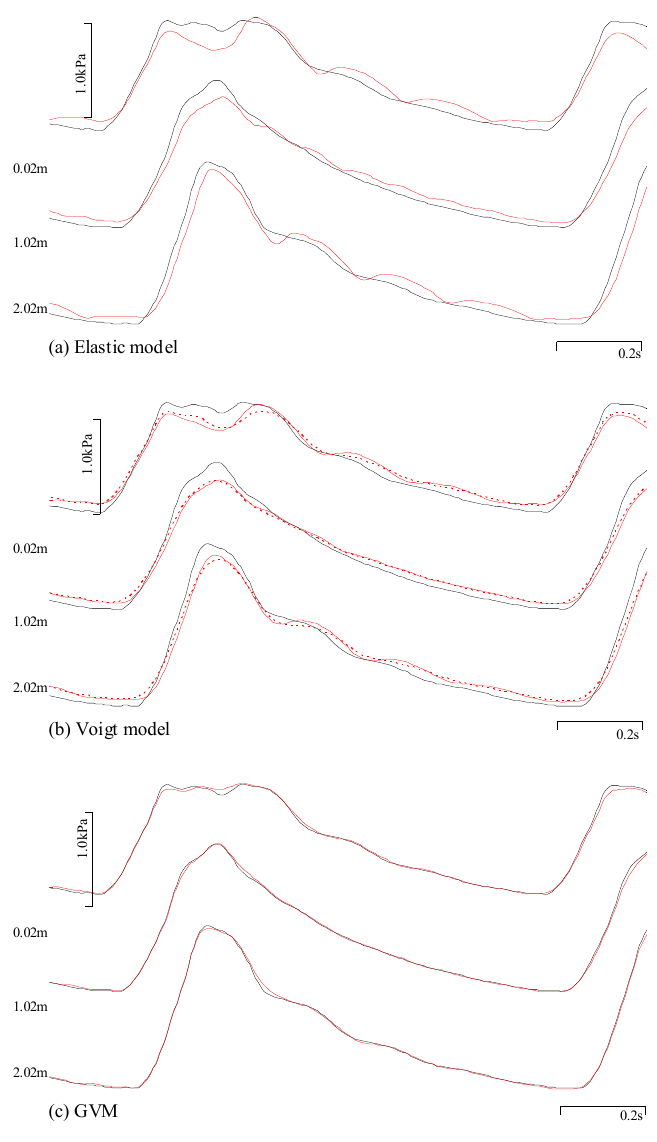
Fig. 7 Calculated pressure waves (thin red line) compared with the measured waves (bold black line) at three locations in the